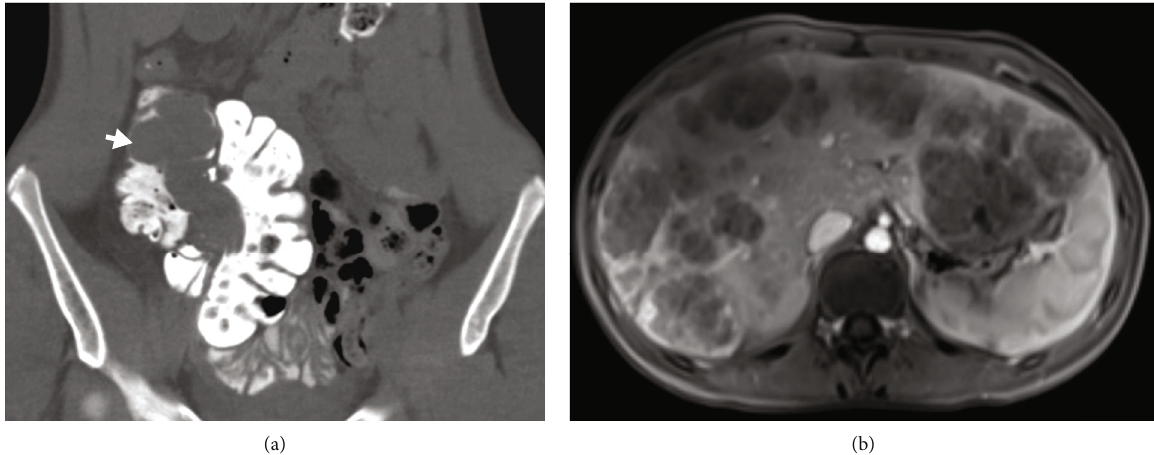
Figure 1: (a) Coronal CT image of the abdomen and pelvis with oral contrast demonstrates an intraluminal mass in the terminal ileum and ascending colon (arrow) serving as a lead point for ileocolic intussusception. (b) Axial T1 fat-saturated postcontrast MRI of the abdomen demonstrates multiple peripherally enhancing lesions throughout the liver consistent with liver